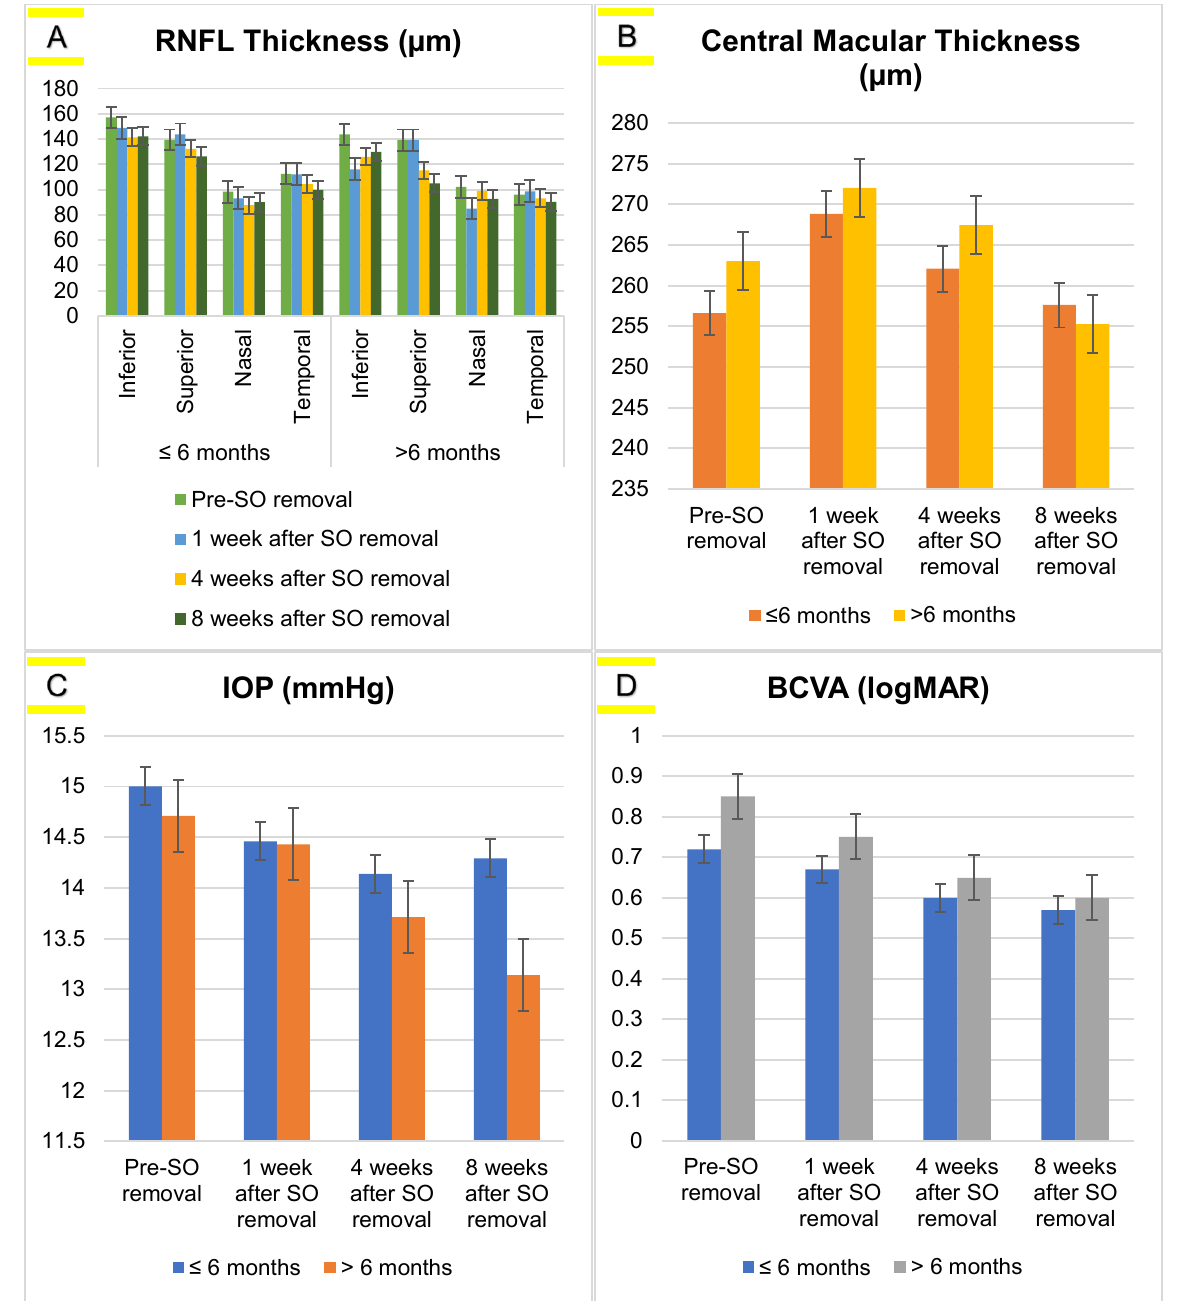
Figure 1. Average values of ( A ) RNFL thickness, ( B ) CMT, ( C ) IOP, and ( D ) BCVA based on the duration of use SO on measurement time of pre- and post-silicone-oil removal in rhegmatogenous retinal detachment patients.